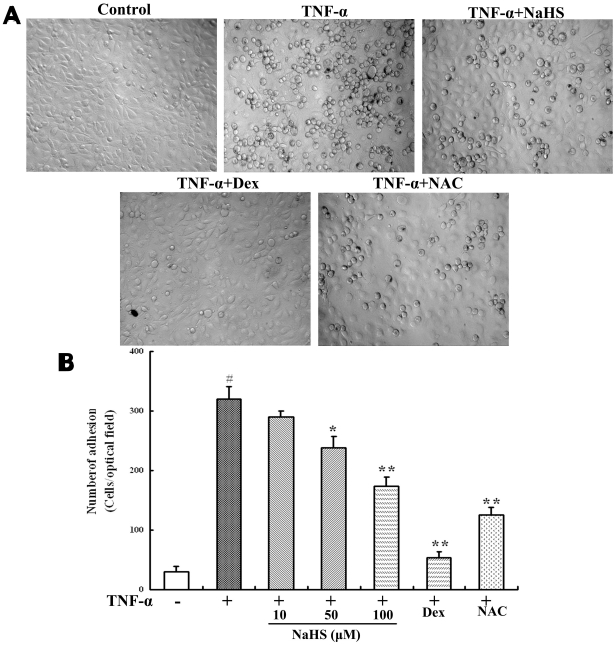
NaHS inhibited U937 cells adhesion to TNF-α-activated HUVEC.HUVEC were incubated with indicated concentrations of NaHS, Dex (10 µM) or NAC (5 mM) for 30 min, then stimulated with TNF-α (10 ng/ml) for 6 h, U937 cells seed onto HUVEC and co-cultured for 2 h. After removing the non-adherent cells, adherent cells were detected and counted under a light microscope. (A) Pictures are representative optical fields. NaHS, Dex, and NAC concentrations were 100 µM, 10 µM, and 5 mM, respectively. (B) Quantitative analysis of the binding of U937 cells to HUVEC presented by bar graphs was counted under a light microscope. #
P<0.05 compared with unstimulated cells, *P<0.05, **P<0.01 compared with TNF-α-stimulated control. Data are the mean ± S.E.M of results from at least three independent experiments, each performed in duplicate.